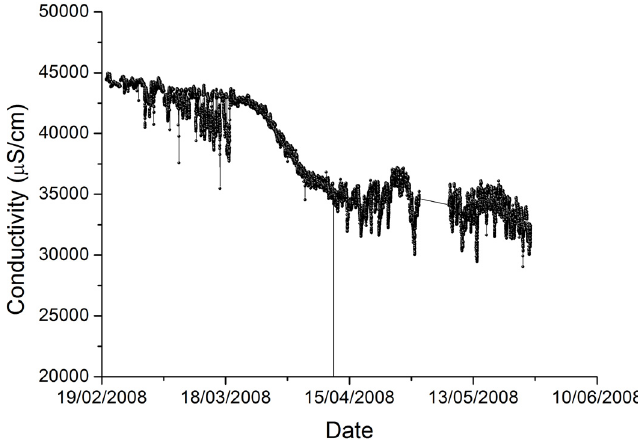
Figure 3. Conductivity data, at a depth of one meter at the CSIRO Wharf, showing an example of a plateau followed by a drop in sensor data